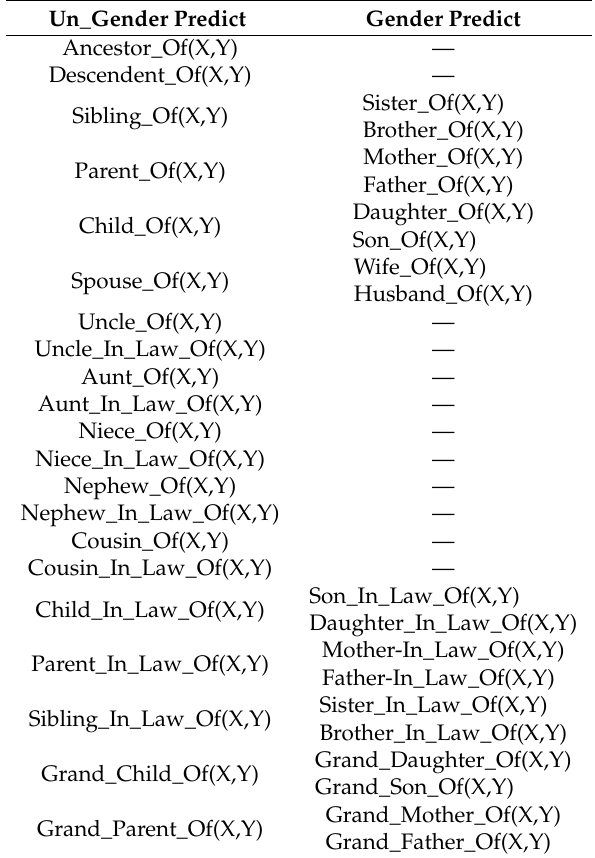
Table 2. Inferred